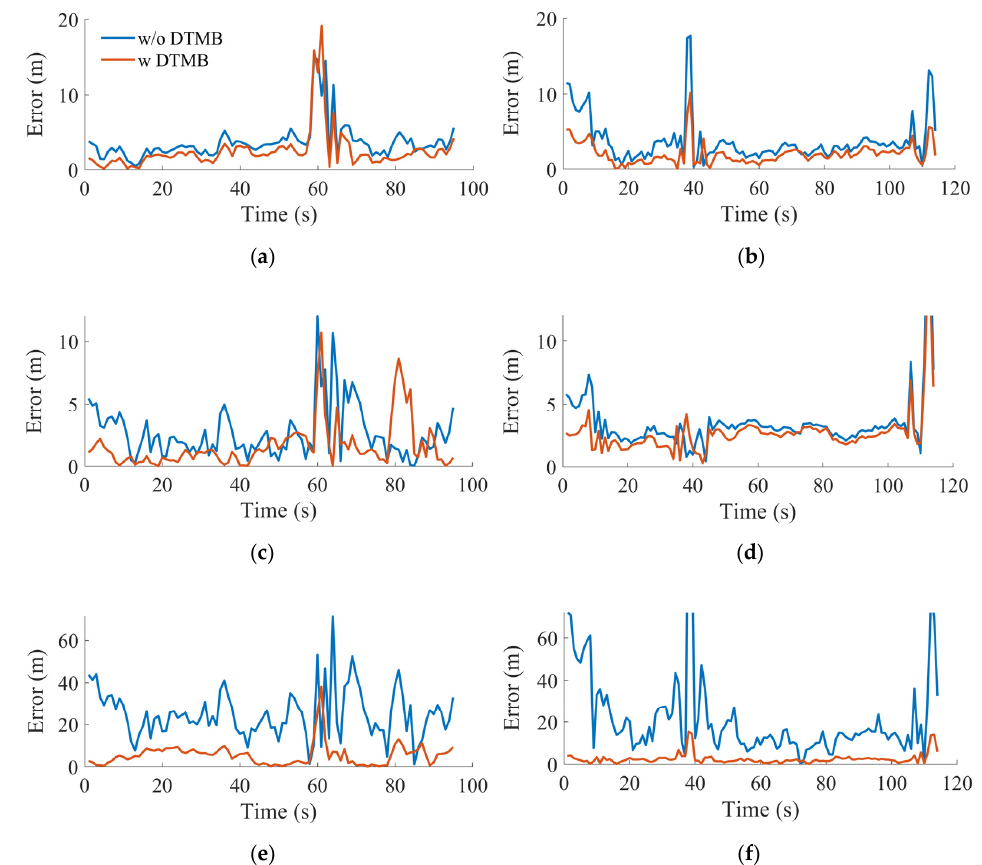
Figure 20. Absolute position error in terms of different directions when 4 satellites are visible. ( a ) Clockwise, east direction. ( b ) Counter-clockwise, east direction. ( c ) Clockwise, north direction. ( d ) Counter-clockwise, north direction. ( e ) Clockwise, up direction. ( f ) Counter-clockwise, up direction.